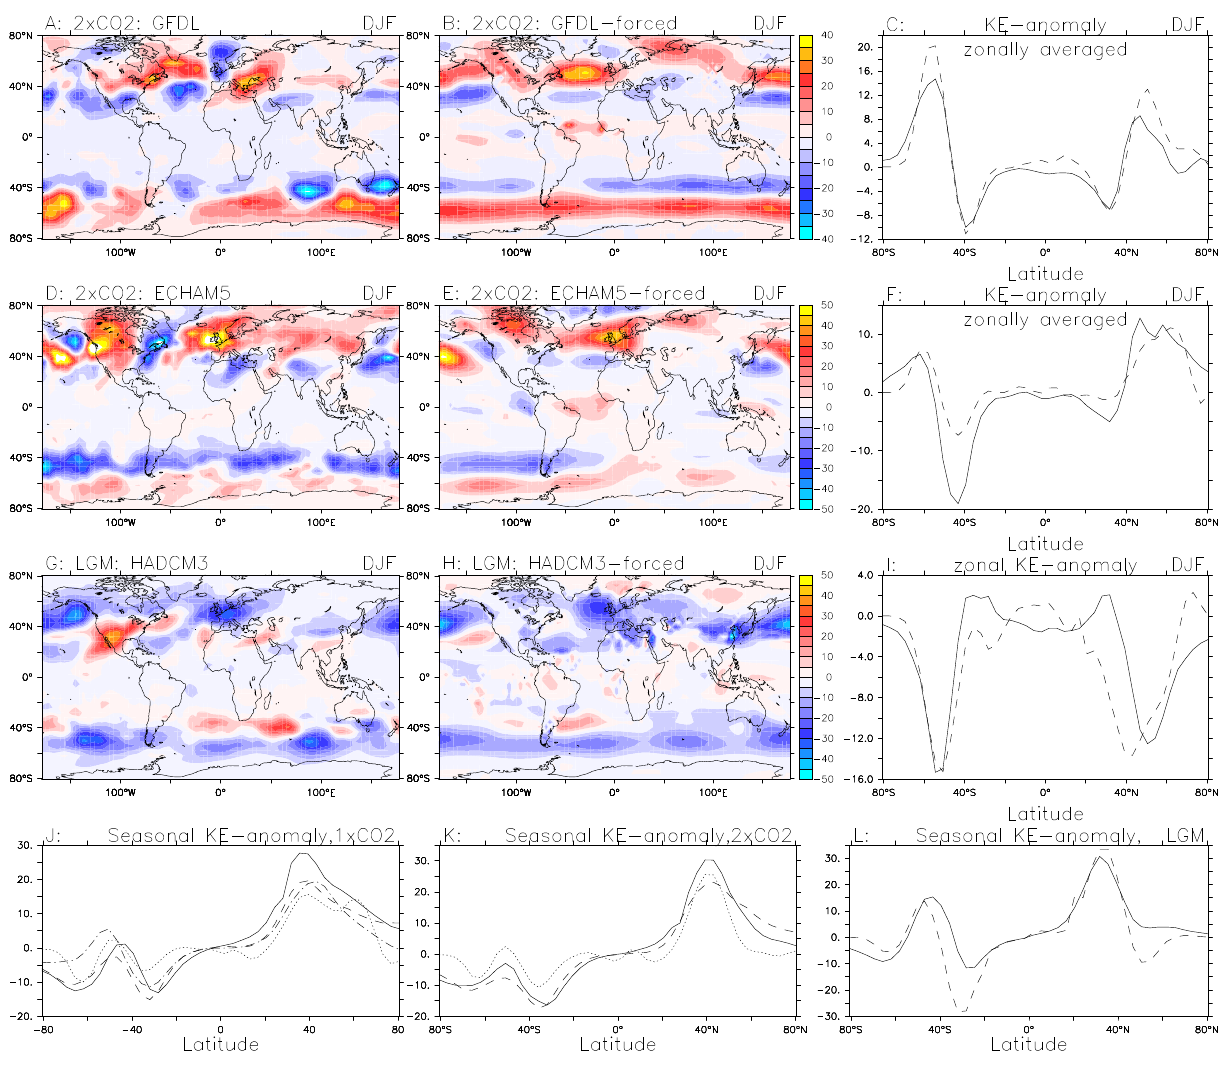
i -anomaly (m 2 s − 2 ) of 2 × CO × CO Fig. 9. h E 0 2 (plots a–f ) and LGM (plots g–i ) climate with respect to their control runs (1 2 ). (a) GFDL k band pass filtered, (b) Aeolus forced with GFDL large-scale long-term wind field, (d) ECHAM5 band pass filtered, (e) Aeolus forced with ECHAM5 large-scale long-term wind field, (g) HadCM3 band pass filtered, (h) Aeolus forced with HadCM3 large-scale long-term wind field. Plots (c) , (f) and (i) give the zonal averages of plots (a, b) and (d, e) and (g, h) , respectively with GCM (solid) and Aeolus (dashed). i -anomaly (DJF-JJA) for (j) 1 × CO × CO Plots (j–l) : seasonal h E 0 2 , (k) 2 2 and (l) LGM climate. In (j) and (k) : GFDL (solid), ECHAM5 k (dashed), Aeolus (dotted), in addition in (j) ERA-40 (dashed-dotted). In (l) HadCM3 (solid) and Aeolus